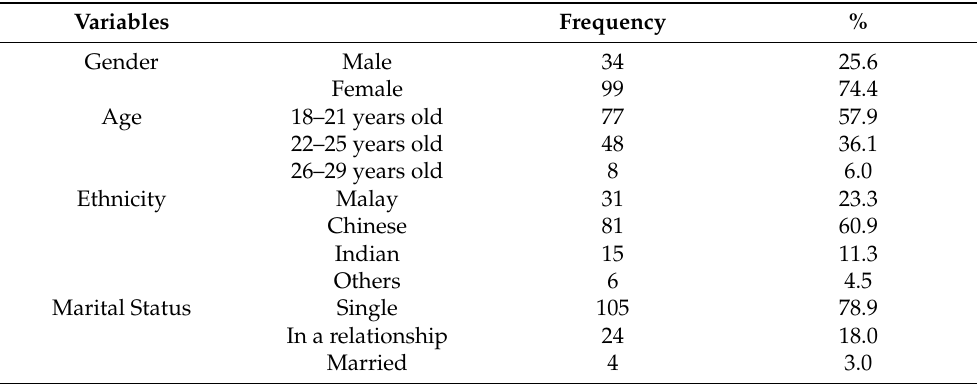
Table 1. Demographic Profile of Respondents ( N =